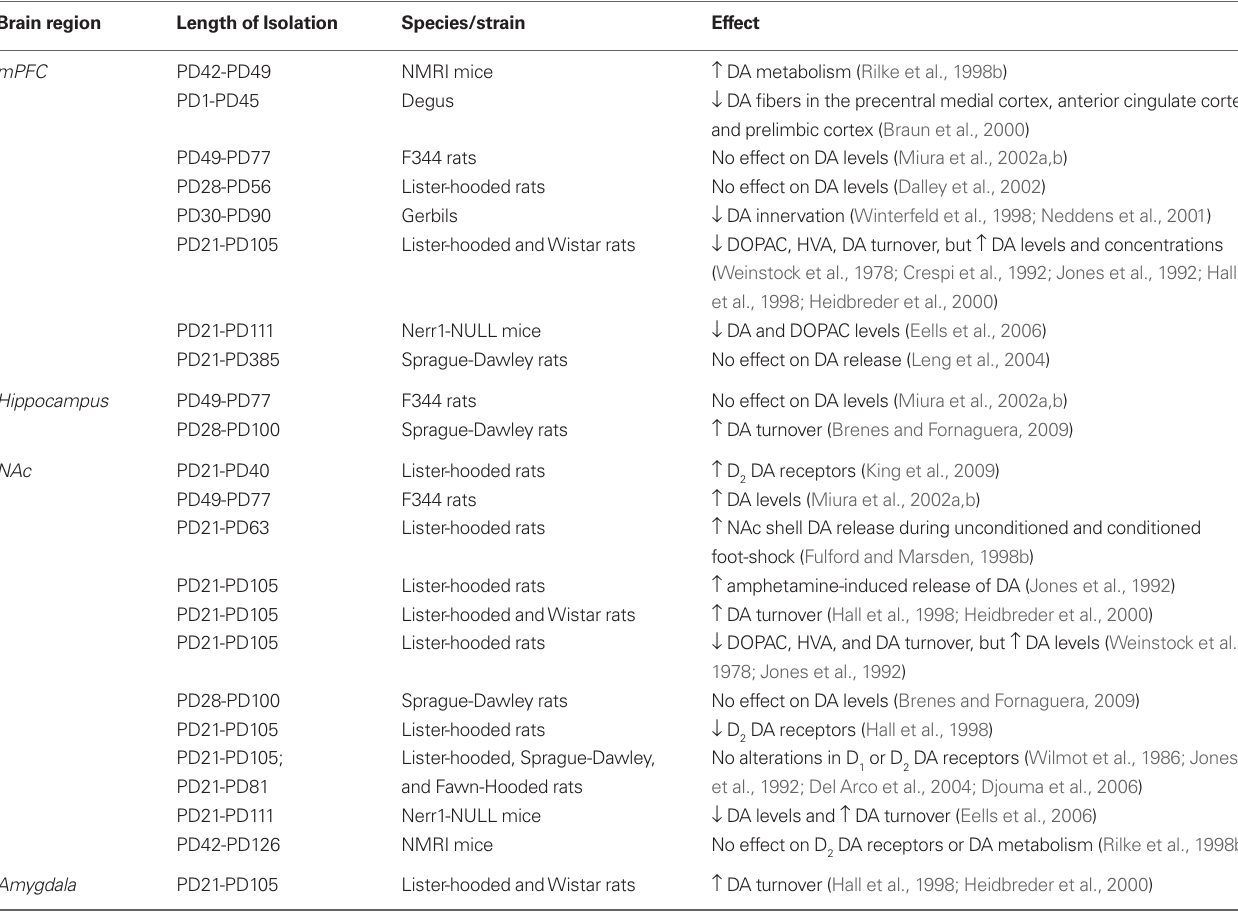
Table 2 | Effects of isolation rearing on dopaminergic function within anxiety-related neural circuits. Brain